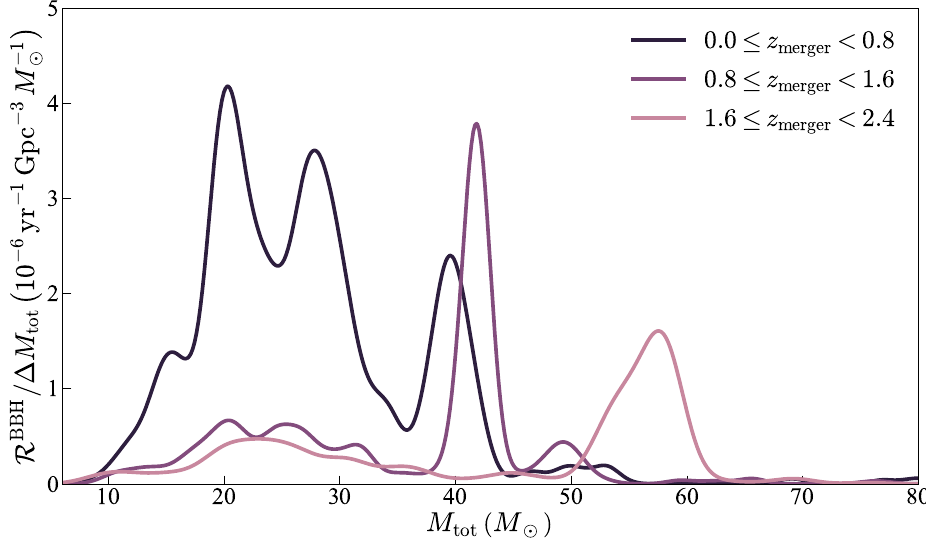
Figure 11. BH-BH merger rate ( R BBH ) per total binary mass ( M tot ) bin in three different ranges of redshift at merger z merger from [193], resulting from binary population synthesis with an IMF that becomes top-heavy at high z